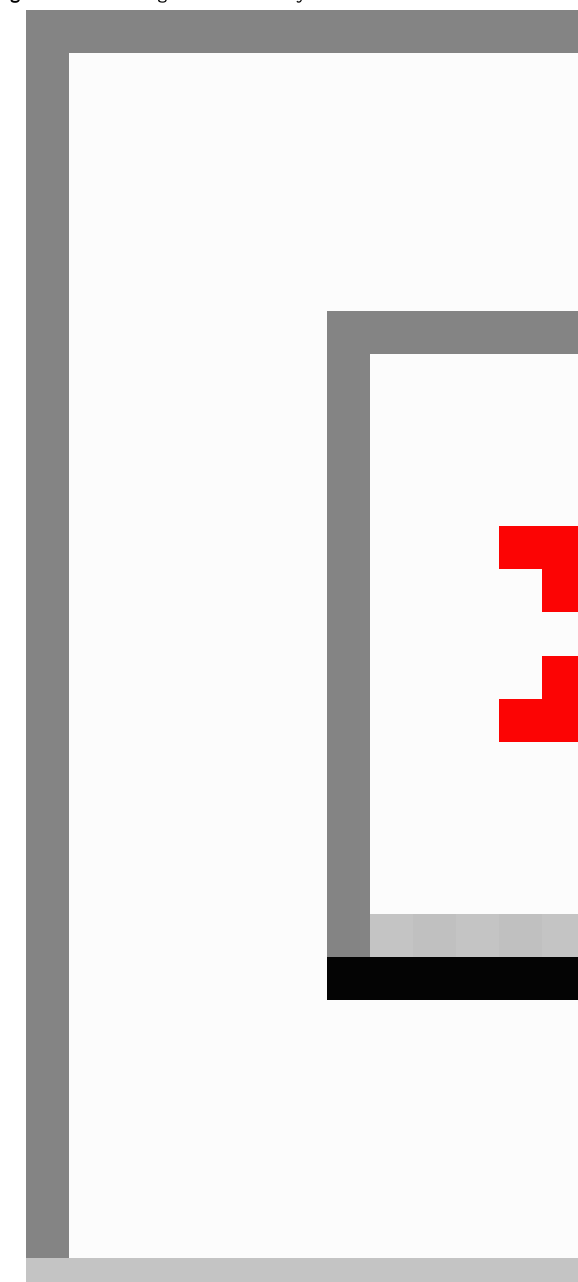
Figure 1. Flow diagram of the